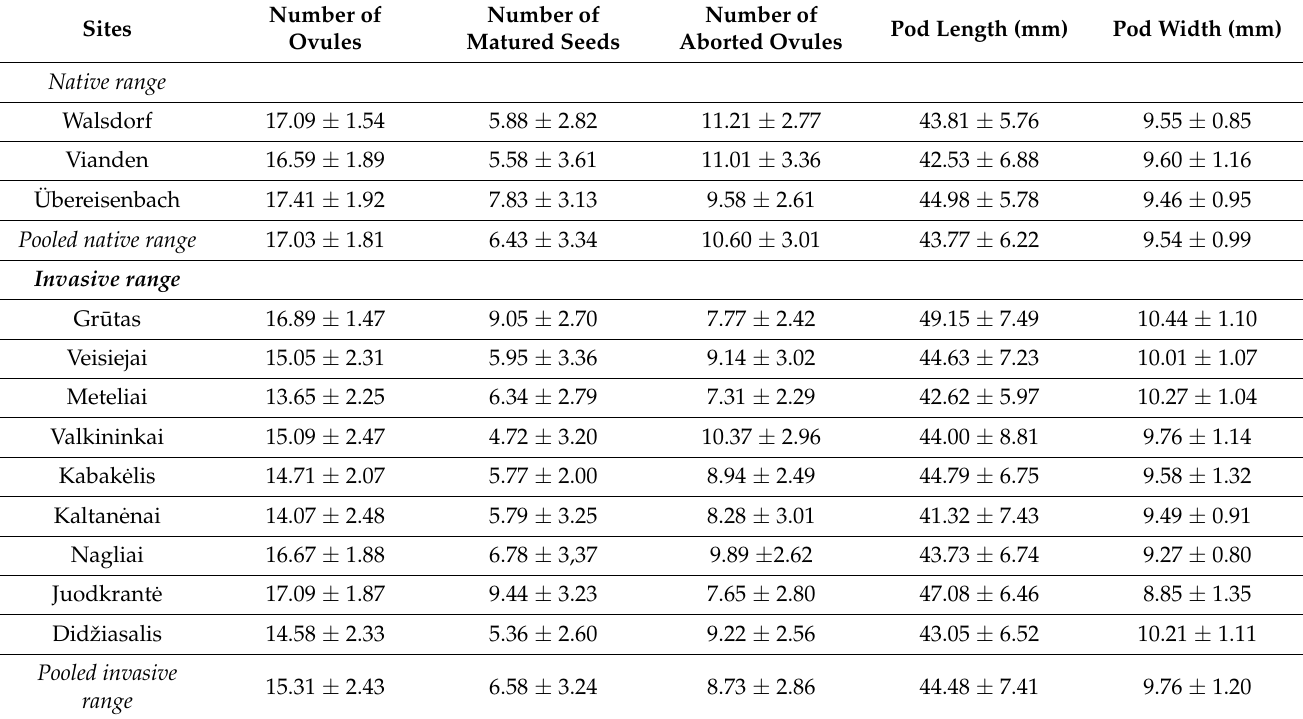
Table 2. Mean values and standard deviations of reproductive traits of Cytisus scoparius at the studied sites in the native and invasive